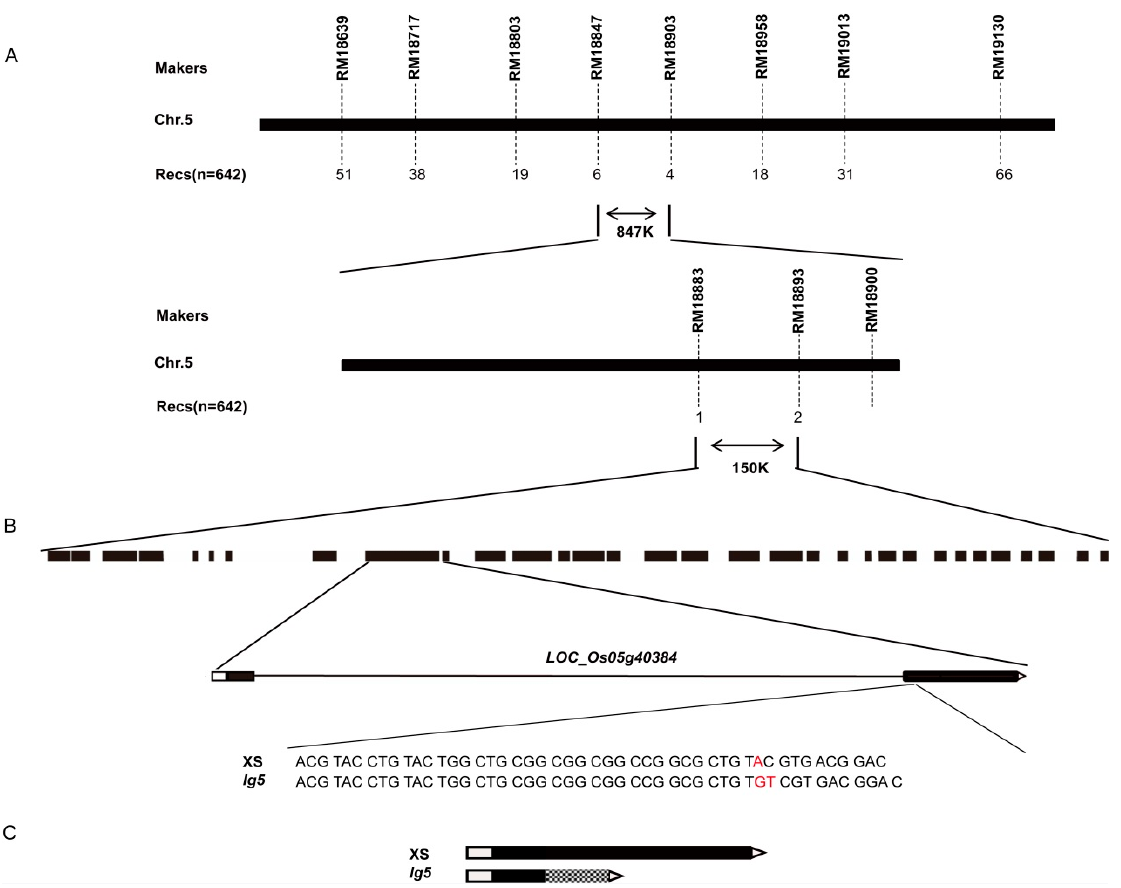
Figure 2. Map-based cloning of LG5 . ( A ) Initial map and fine mapping of LG5; the numbers beneath the marker positions indicate the number of recombinants (recs). ( B ) A total of 33 candidate genes and LOC_Os05g40384 gene substitution (depicted in red). ( C ) LOC_Os05g40384 coding sequence (CDS) between XS and lg5 ; the shaded area represents the changed translation and premature termination.